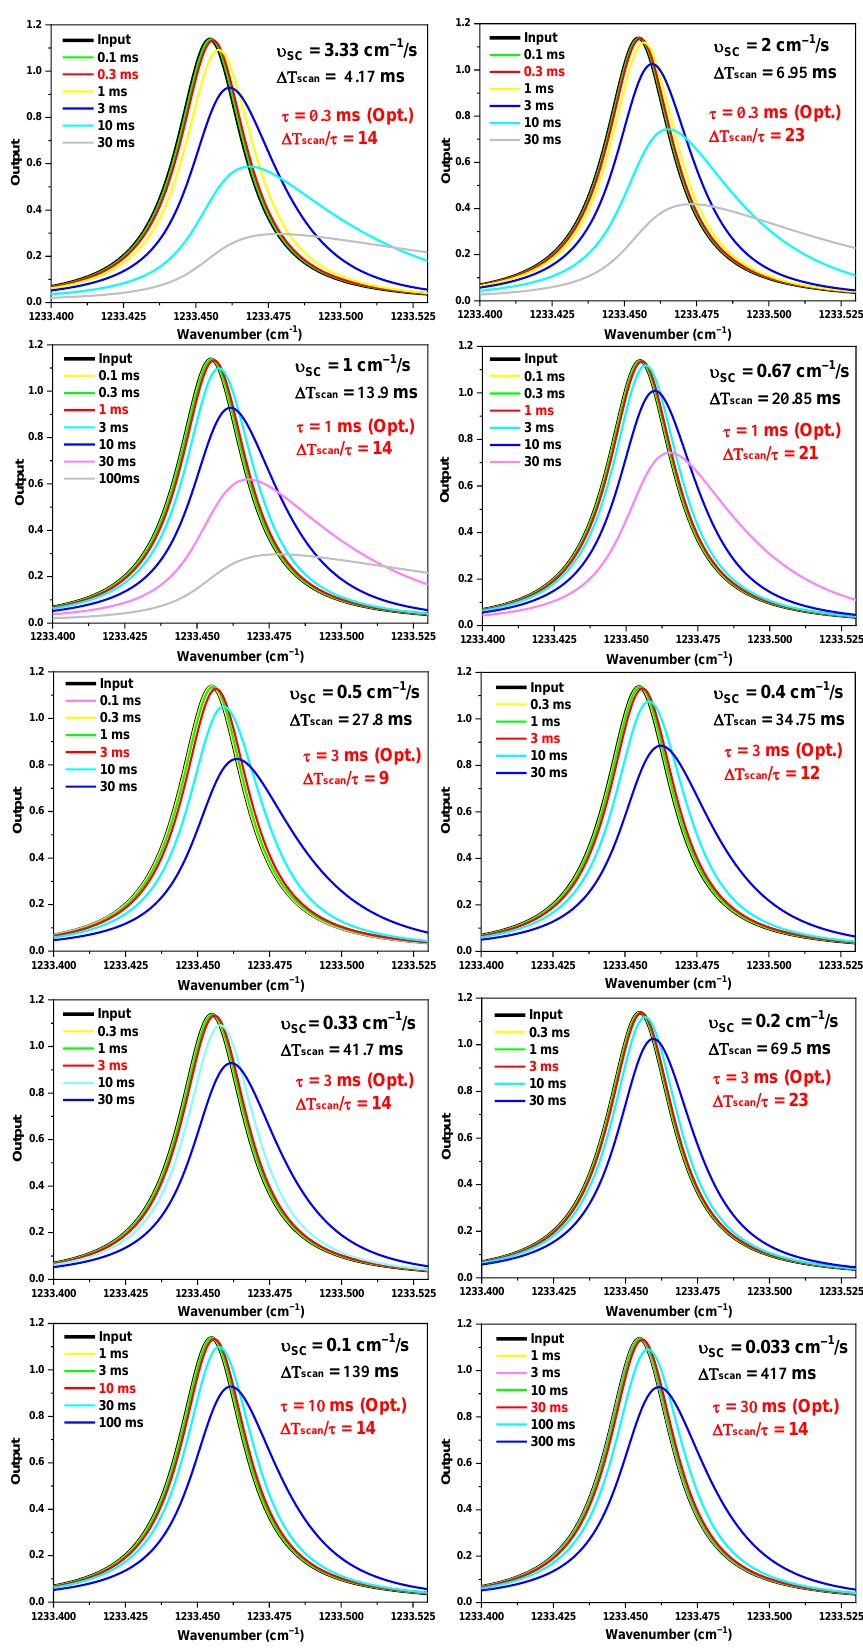
Figure 3. Simulation of output spectra from the LP filter using different parameters (see Table 1), in comparison to the Hitran simulation of input spectrum of CH 4 near 1233.45 cm −1 .